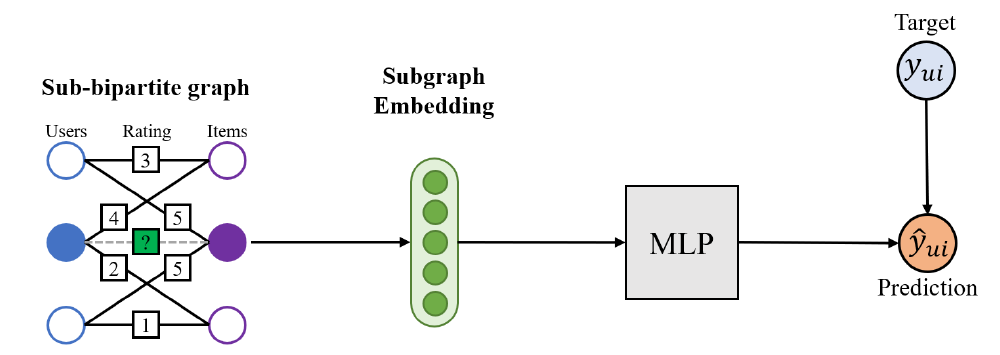
Figure 1. Link prediction process of